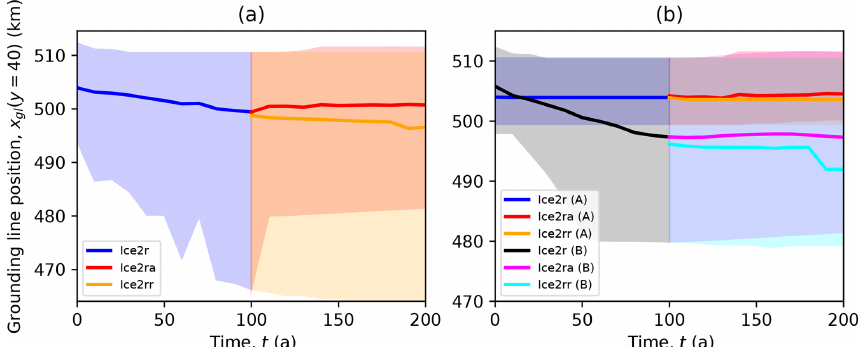
Figure 14. Domain edge grounding line position plotted against time for the Ice2 experiments. Panel (a) shows the mean (solid curves) and the range (shaded regions) for the main subset. Panel (b) shows the mean (solid curves) and range (shaded regions) for two subgroups, Ice2A and Ice2B. Models in subgroup Ice2A see little or no grounding line retreat along the domain